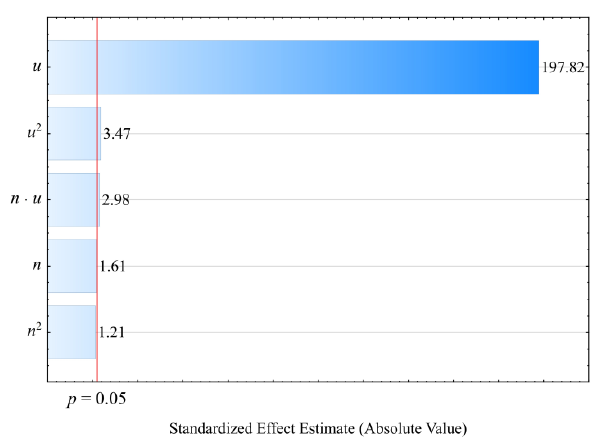
Figure 7. Pareto plots of the standardized effects of empirical full model density ρ , the vertical line in the plot corresponds to the arbitrarily chosen level of significance ( p = 0.05).